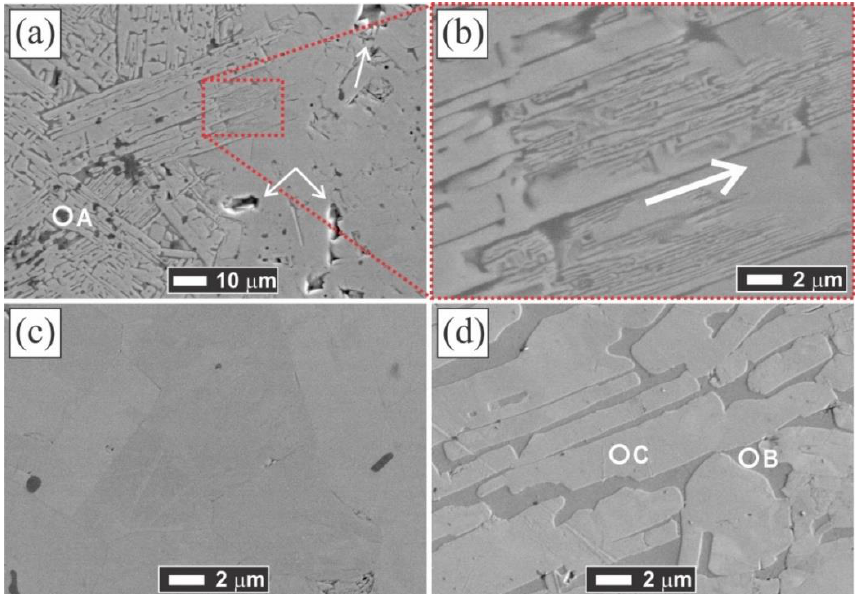
Figure 3. SEM images of: ( a ) the outer border of the polished and non-etched MAX-1200 sample; ( b ) zoom of the “transition zone”; ( c ) the middle of the sample (showing a nearly single bulk Ti 2 AlN MAX phase); and ( d ) underdeveloped Ti 2 AlN. The EDS point analysis carried out revealed that the zones A, B, and C correspond to Al 2 O 3 , Ti 3 Al, and Ti 4 AlN 3 ,